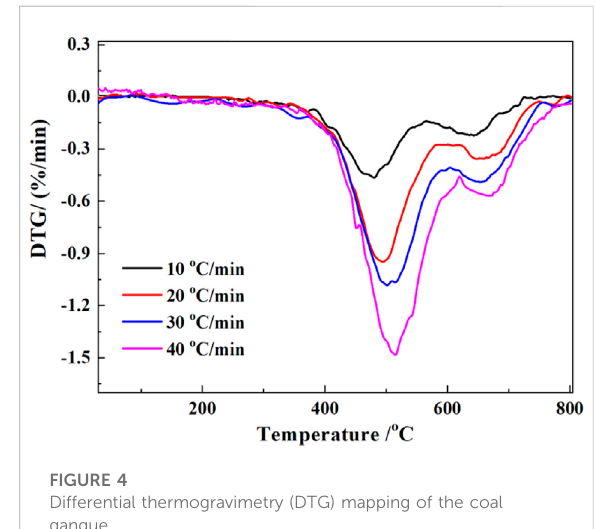
FIGURE 3 Thermogravimetry analysis (TGA) patterns of the coal gangue.